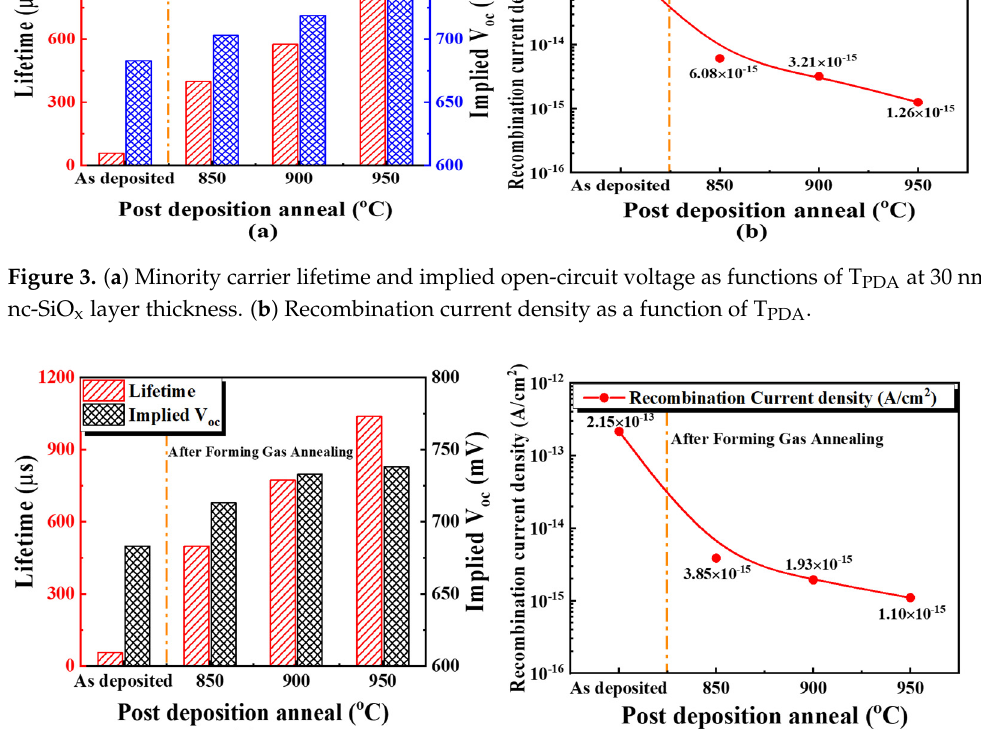
Figure 4 . ( a ) Improvement in minority carrier lifetime and implied open-circuit voltage as a function of T PDA and FGA. ( b ) Improvement in rear recombination current density as a function of T PDA and